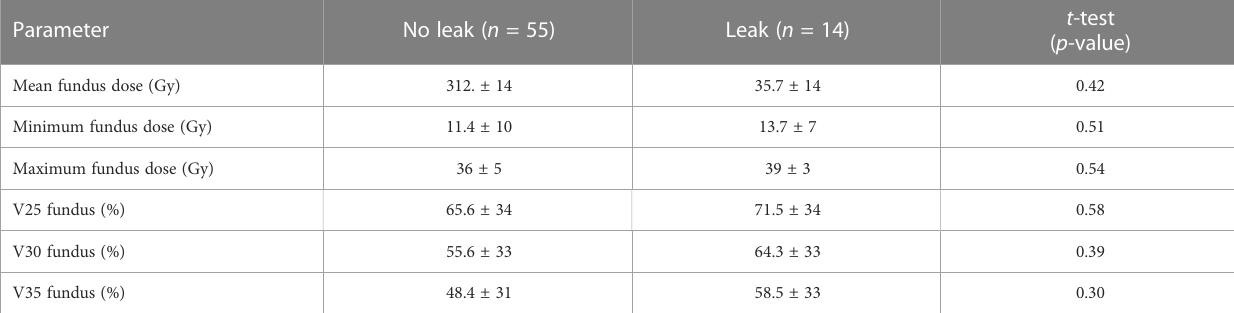
TABLE 2 Gastric fundus radiation dose parameter comparison between those without and those with anastomotic